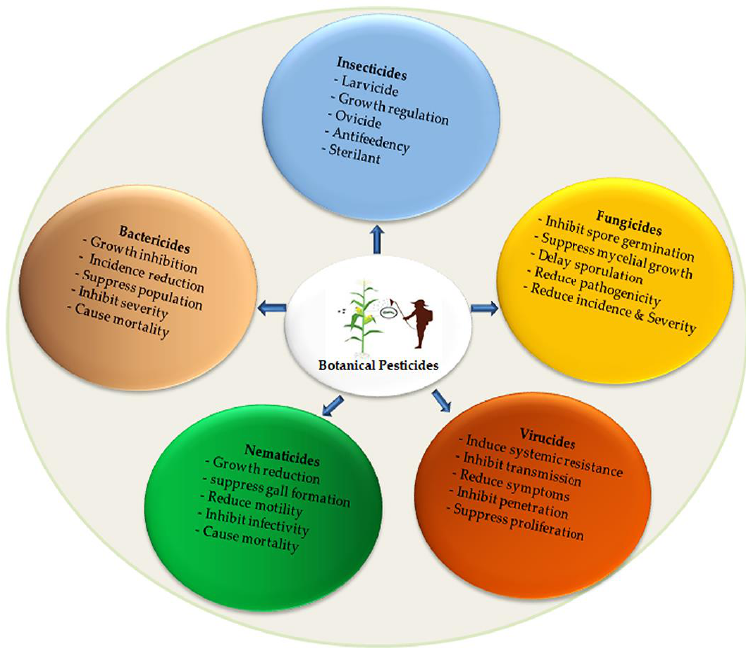
Figure 1. Illustration of botanical pesticides application in agriculture.